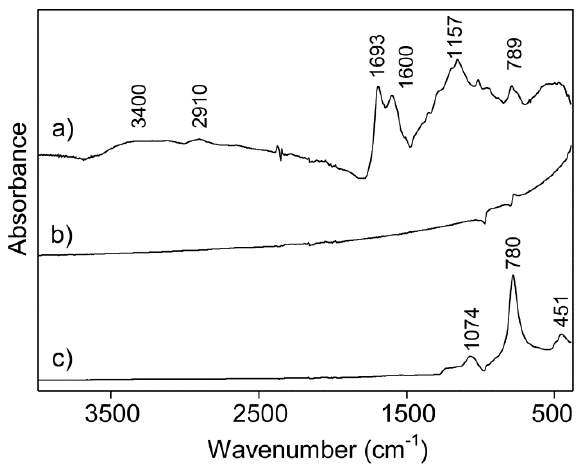
Figure 6. IR spectra of ( a ) hydrochar prepared from glucose, ( b ) a core-shell C-SiC composite, and ( c ) hollow and spherical SiC particles.